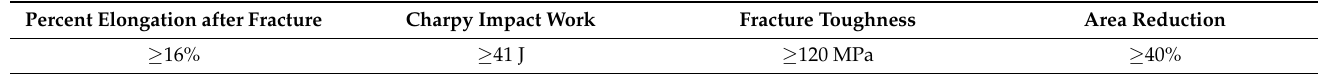
Table 2. Material property specifications for ultrahigh-pressure vessels.